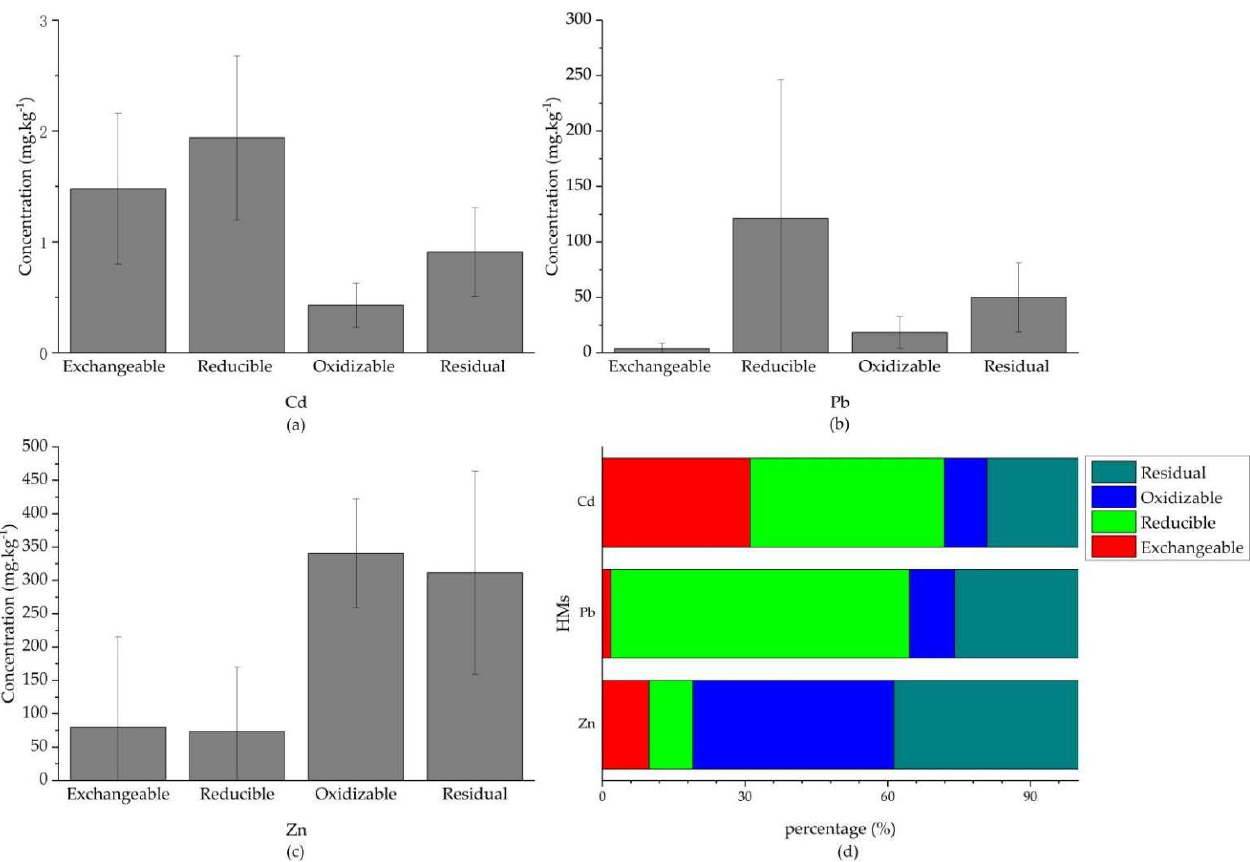
Figure 7. Distribution of chemical fractions for Cd, Pb and Zn ( a – c ) and percentages of four chemical fractions for each element ( d ).